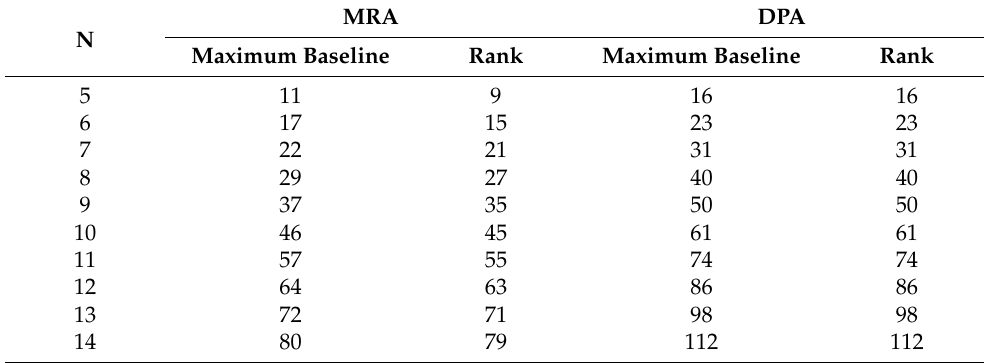
Table 2. Performance comparison.